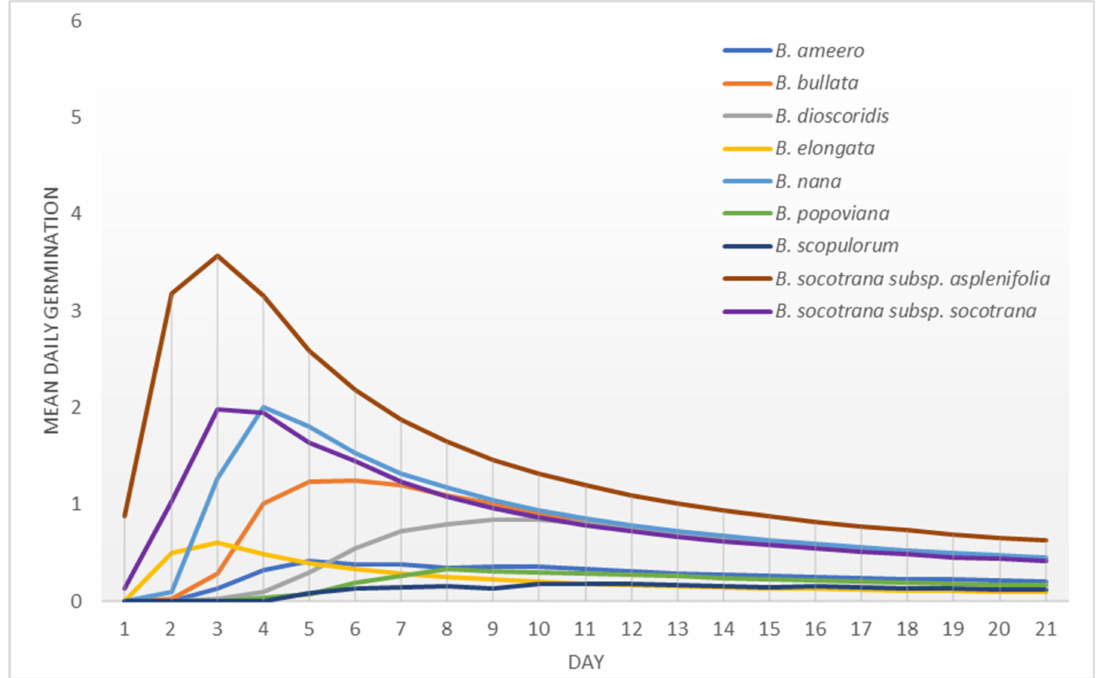
Figure 9. Peak value indexes of seeds of different Boswellia taxa from Socotra sampled in